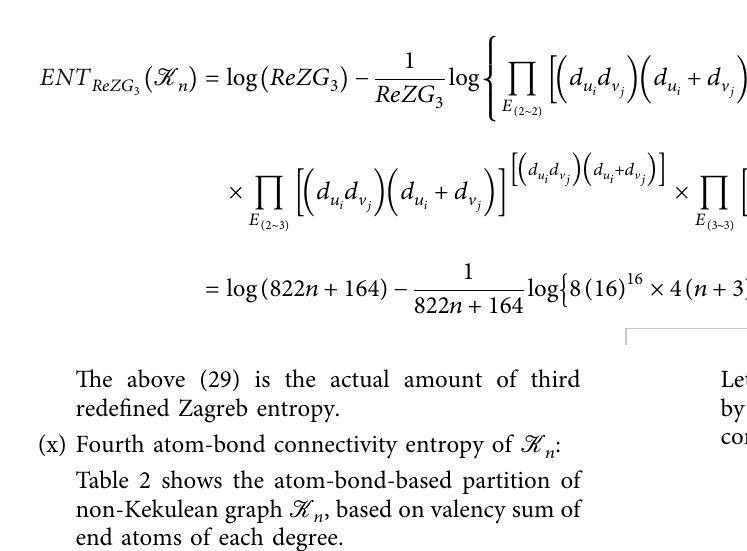
K K K K K ReZG ReZG ABC GA n ) , n ) , n ) , n ) , n ) , and 1 ( 2 ( 3 ( 4 ( 5 ( K K K K ENTReZG ENTABC ENTGA n ) , n ) , n ) , and n ) 2 ( 3 ( 4 ( 5 (